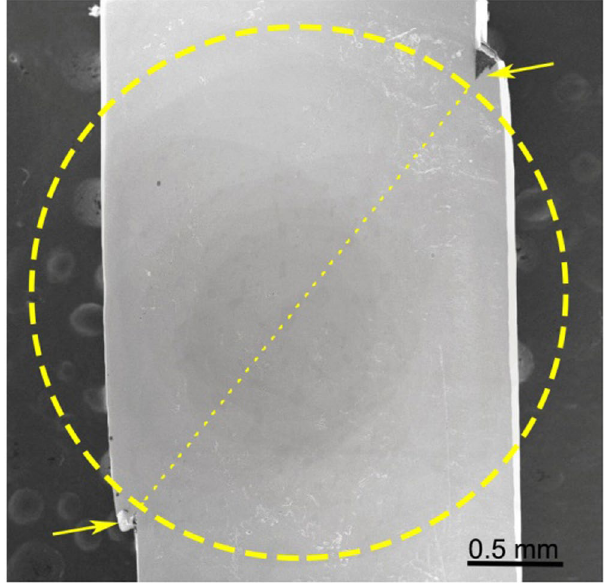
Figure 4. The SEM image of longitudinal section of the deformed sample shown in Fig. 2. The dotted line is expected to be the path of the shear band, and the region enclosed by the dashed circle is taken to prepare the TEM sample in Fig.